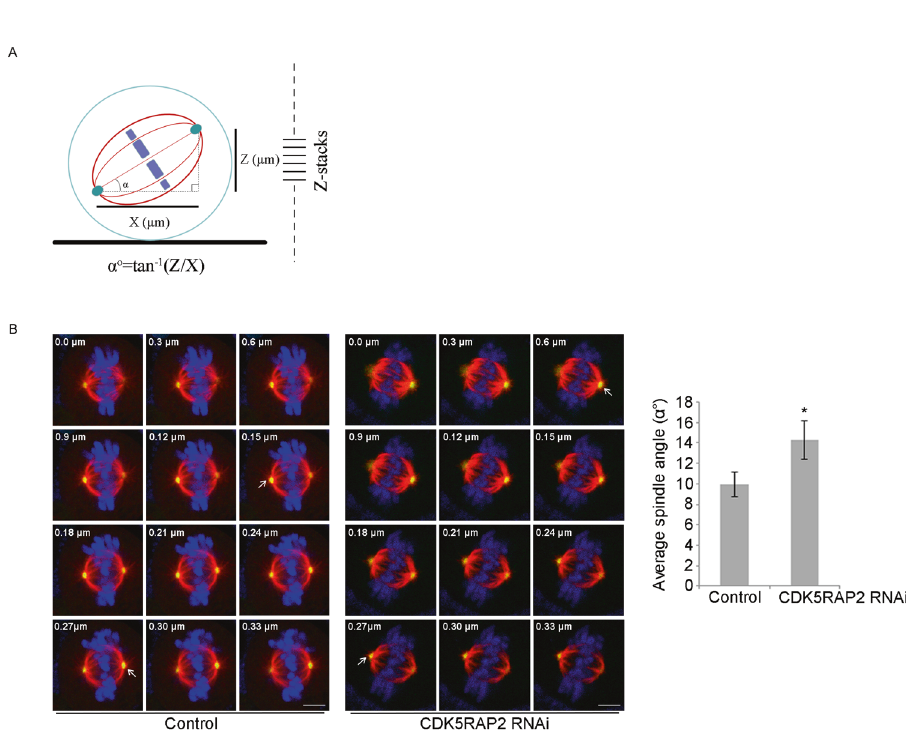
Fig. 6 CDK5RAP2 regulates spindle orientation. A Schematic depicting calculation of spindle angles. The horizontal distance (X μ m) and the vertical distance (Z μ m) between two spindle poles of metaphase cells were measured by acquiring Z-stack images. Spindle angle ( α ο ), the angle between the spindle axis and the substrate plane, was calculated using an inverse trigonometric function. B Representative Z-stack images of metaphase cells. HeLa cells were fi xed and immunostained with anti- α -tubulin and anti- γ -tubulin antibodies. White arrows indicate the focal planes of two spindle poles in two different sections. Scale bars, 5 μ m. The spindle angle of HeLa cells after control or CDK5RAP2 knockdown was quanti fi ed. Data are presented as means ± SD; * P < 0.05, two-tailed Student ’ s t